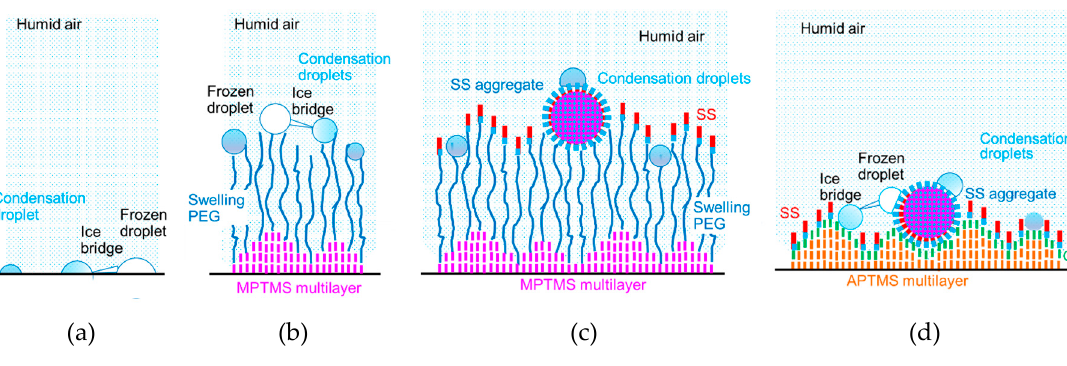
Figure 7. Locations of condensation droplets and frozen droplets on the specimen surfaces: ( a ) Glass ; ( b ) PEG ; ( c ) PEG-SS ; ( d ) GA-SS . Blue colors show more hydrophilic materials or surfaces, while red, pink and orange colors show more hydrophobic materials or surfaces.